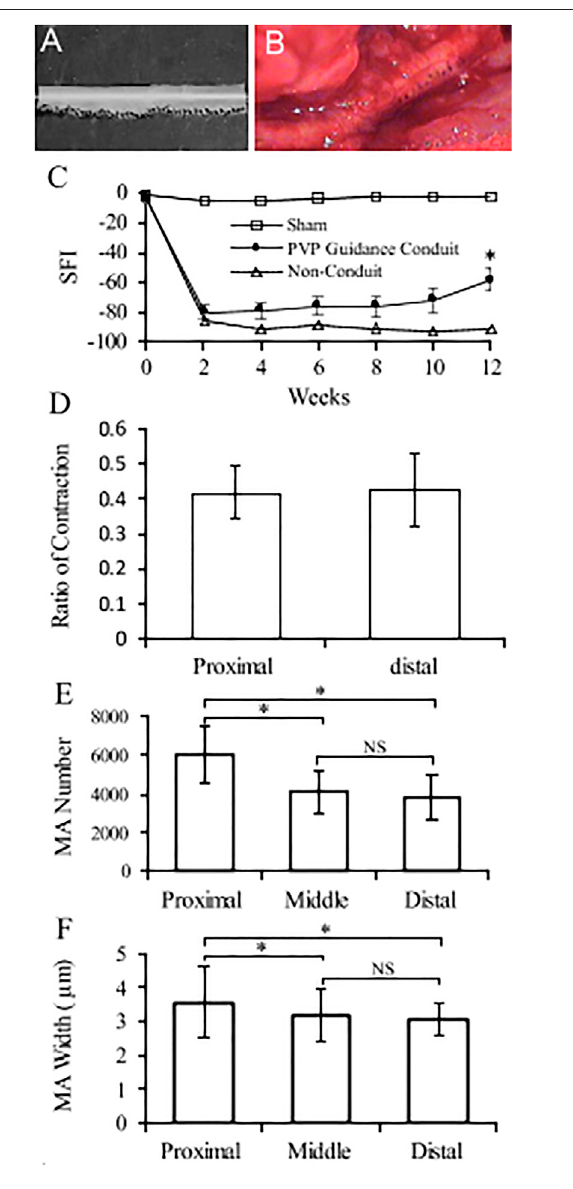
FIGURE 5 | Nerve conduit guidance and parameters of nerve regeneration in sciatic model of rats. (A) An example of conduit guidance before implantation. (B) An example of conduit guidance at postop 12 weeks. (C) Biweekly changes of SFI in rodent sciatic nerve. Sham: non-injury to the sciatic nerve during the sciatic nerve exposure and skin closure. PVP guidance conduit: The sPVP nerve guidance conduit implanted when the sciatic nerve excised. Non-conduit: no guidance conduit implanted when the sciatic nerve was excised. (D) Ratios of the ipsilateral tetanic contractions of sPVP nerve guidance conduit to contralateral tetanic contractions of the gastrocnemius muscle. Proximal and distal: abipolar electrode wasplaced at the proximal or distal end ofthe sPVP nerve guidance conduit, respectively. (E) The number of myelinated axonsintheproximal,middle,anddistalregionsofthesPVPnerveguidance conduit, respectively. (F) The average width of myelinated axons in the proximal, middle, and distal regions of the sPVP nerve guidance conduit, respectively. SFI: sciatic function index. MA: myelinated axons. *: p < 0.05. NS: p >